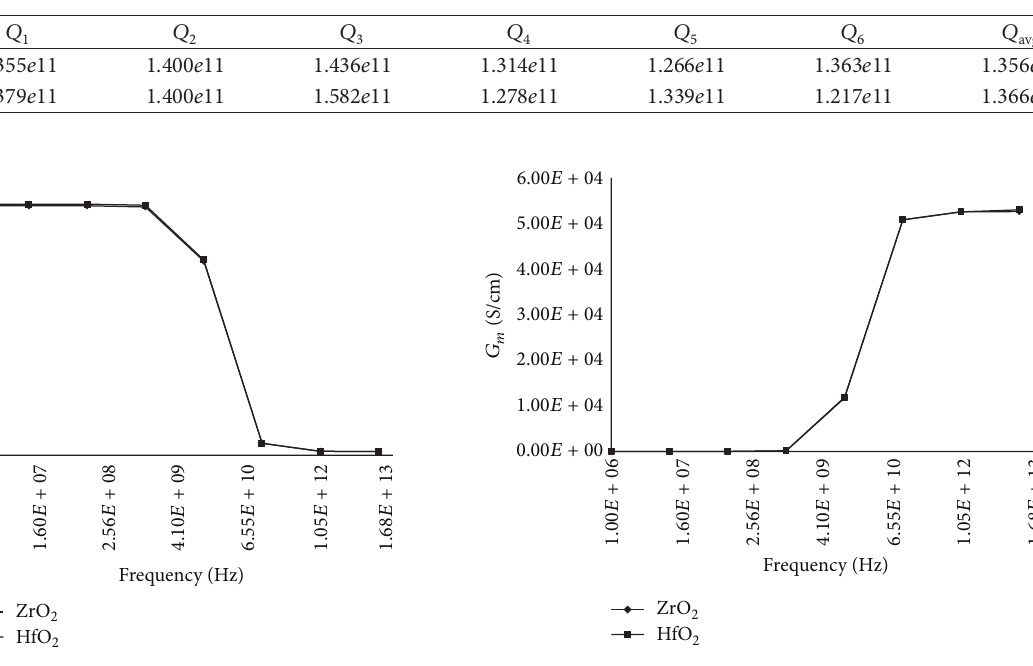
in SiO and different high- 𝑘 material. it 2